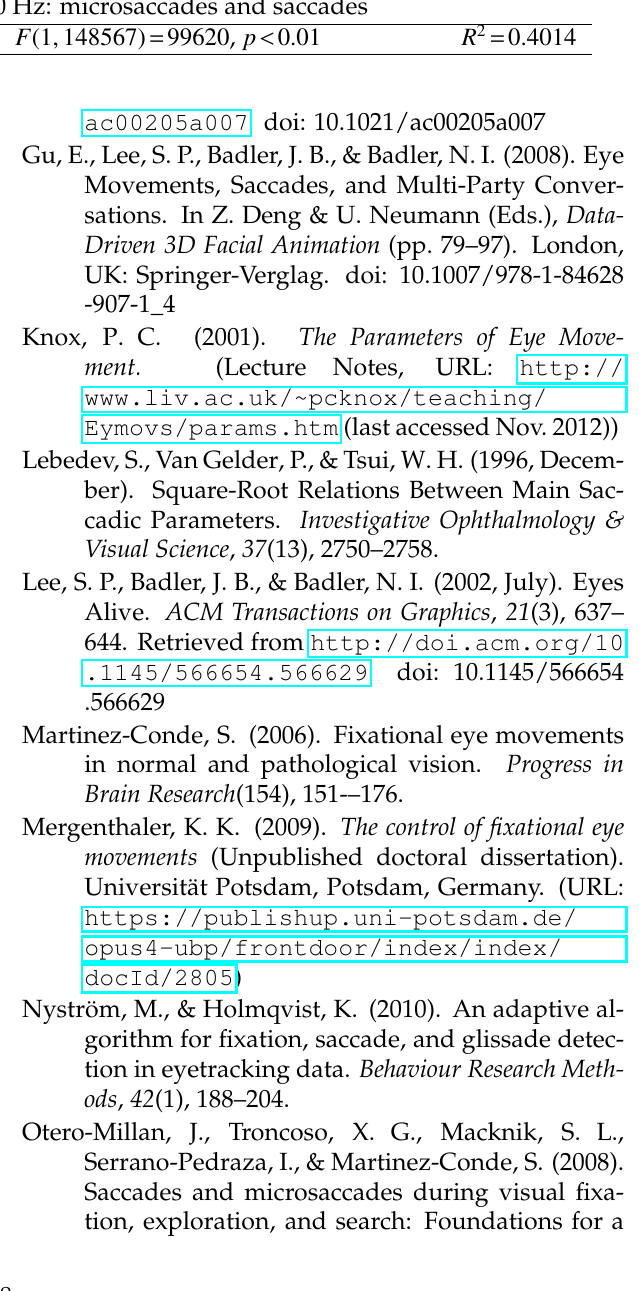
Linear fit analysis for the inverse-linear logistic and linear model fit to all data sets. Linear